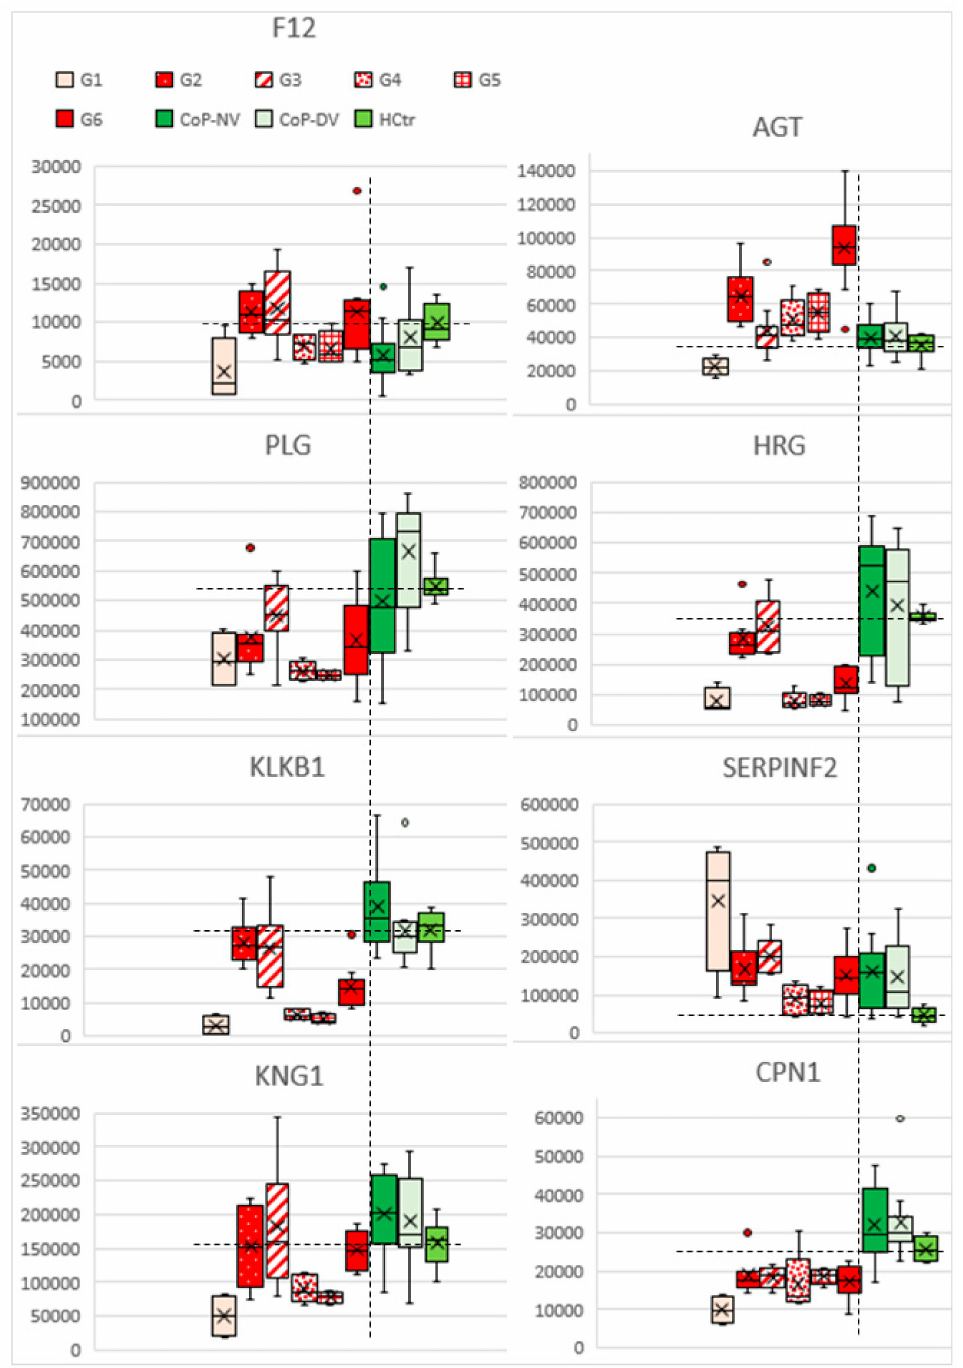
Figure 8. Boxplots of the accumulated ion intensities of eight selected proteins of the RAS and KKS networks (for illustration, see Figures 7 and 5E) for G1–G6. The horizontal dashed lines indicate the mean for HCtr for improved data comparison; the vertical dashed lines separate HoP from